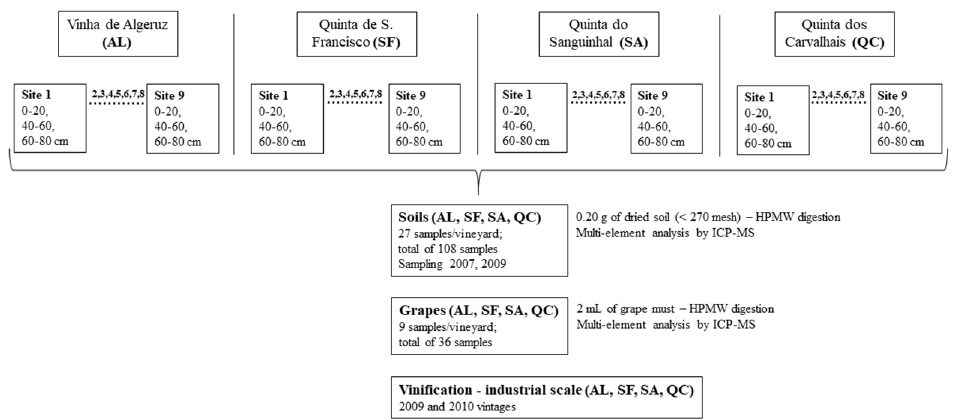
Figure 1. Schematics of the sampling strategy and analytical procedures used in this study.